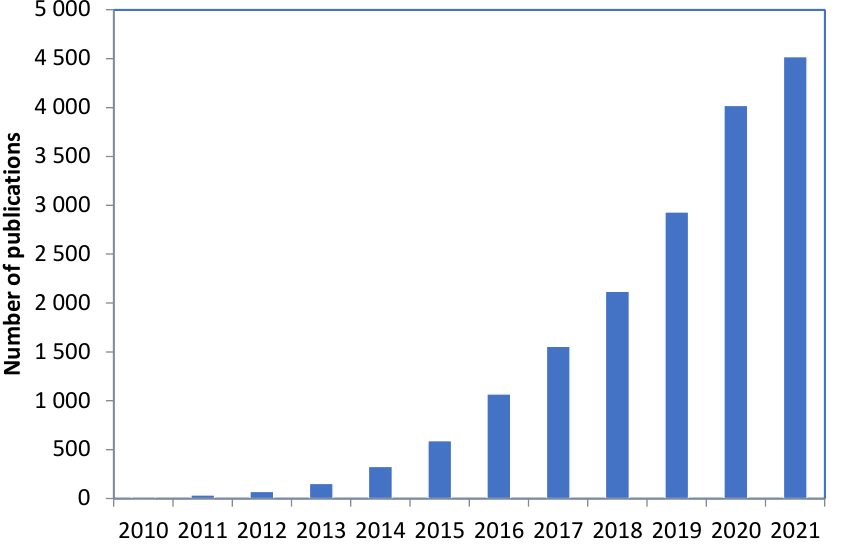
Figure 5. The number of publications of GO in UF membranes in 2010–2021 (Google Scholar).